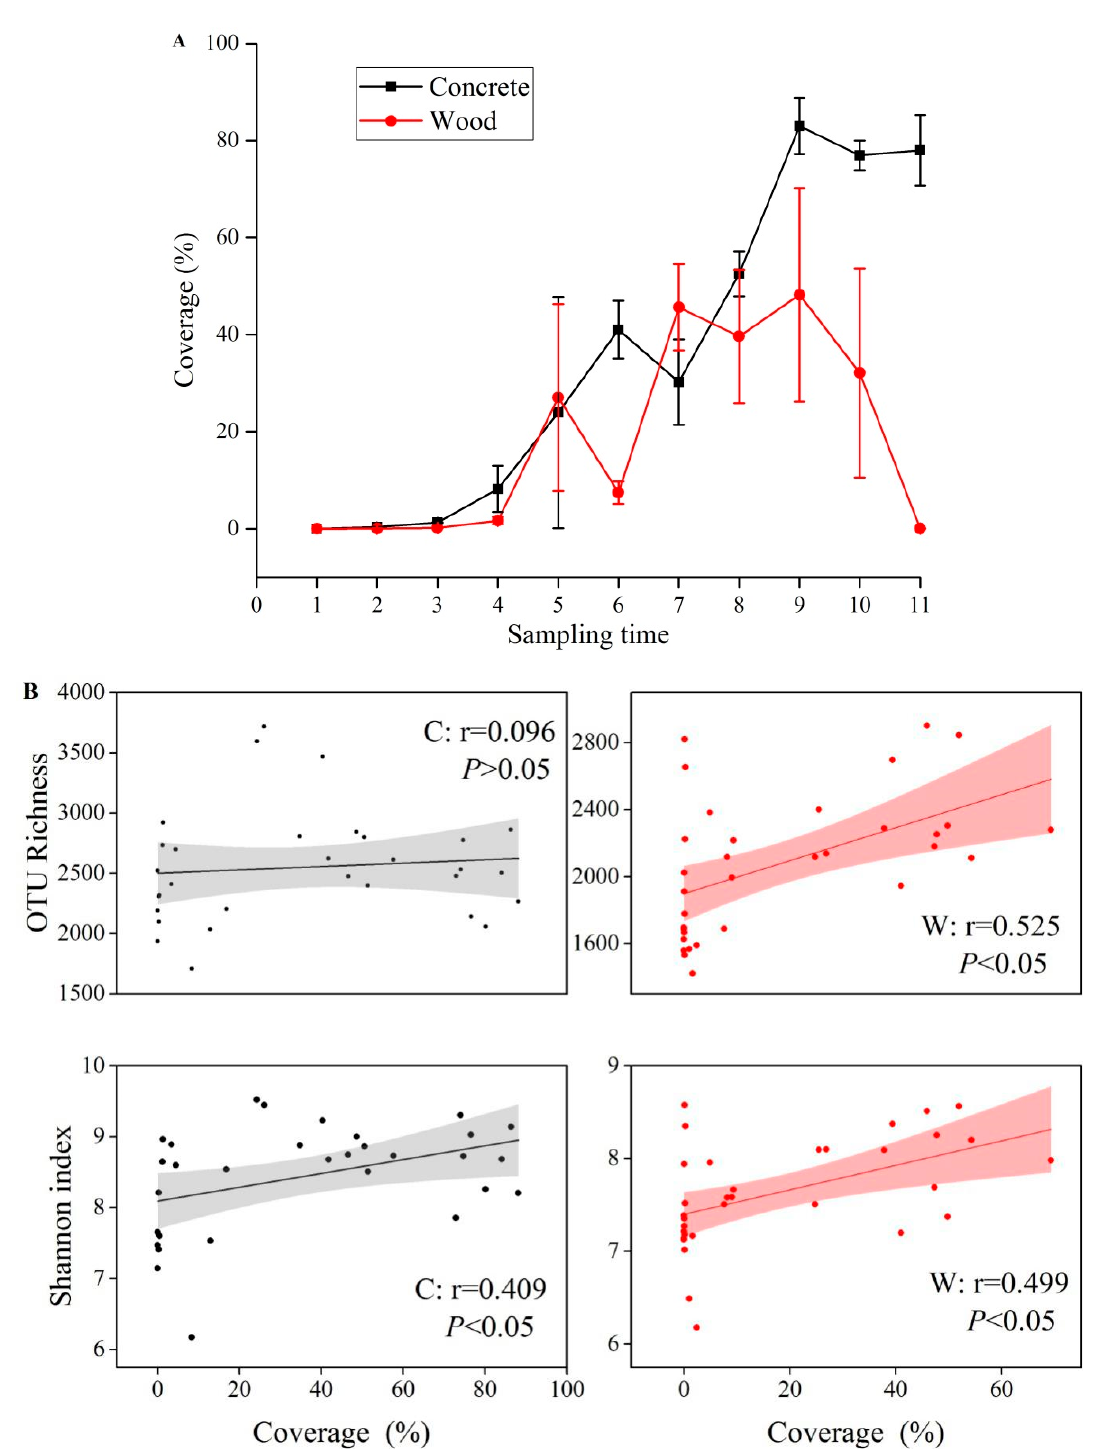
Figure 6. Dynamics of macrobenthic coverage over time ( A ) and Pearson plots of microbial OTU richness and Shannon index against macrobenthic coverage ( B ) on concrete and wood.